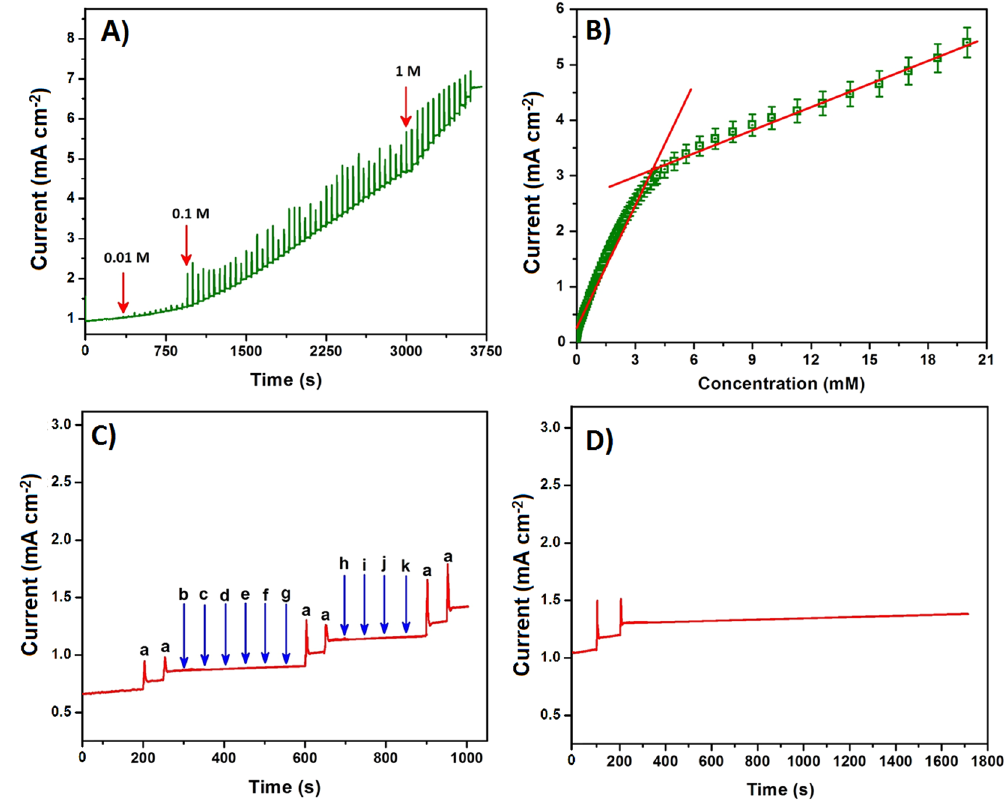
Figure 6. Amperometric responses of the glucose oxidation at S-rGO/CuS/RDE with the successive additions of various concentration of the glucose from 100 nM to 21.3 mM in 0.1 M NaOH at an applied potential of 0.48 V ( A ). The corresponding calibration plot of oxidation peak current vs. concentration of glucose ( B ). Amperometric signal for the glucose (a) oxidation at S-rGO/CuS/RDE with the interferences such as sucrose (b), fructose (c), lactose (d), galactose (e), Na + (f), NO 3 − (g), H 2 O 2 (h), UA (i), DA (j) and AA (k) in 0.1 M NaOH ( C ). The amperometric profile for the stability test carried out at S-rGO/CuS/RDE with the addition of 0.2 mM glucose in 0.1 M NaOH up to 1400 s ( D